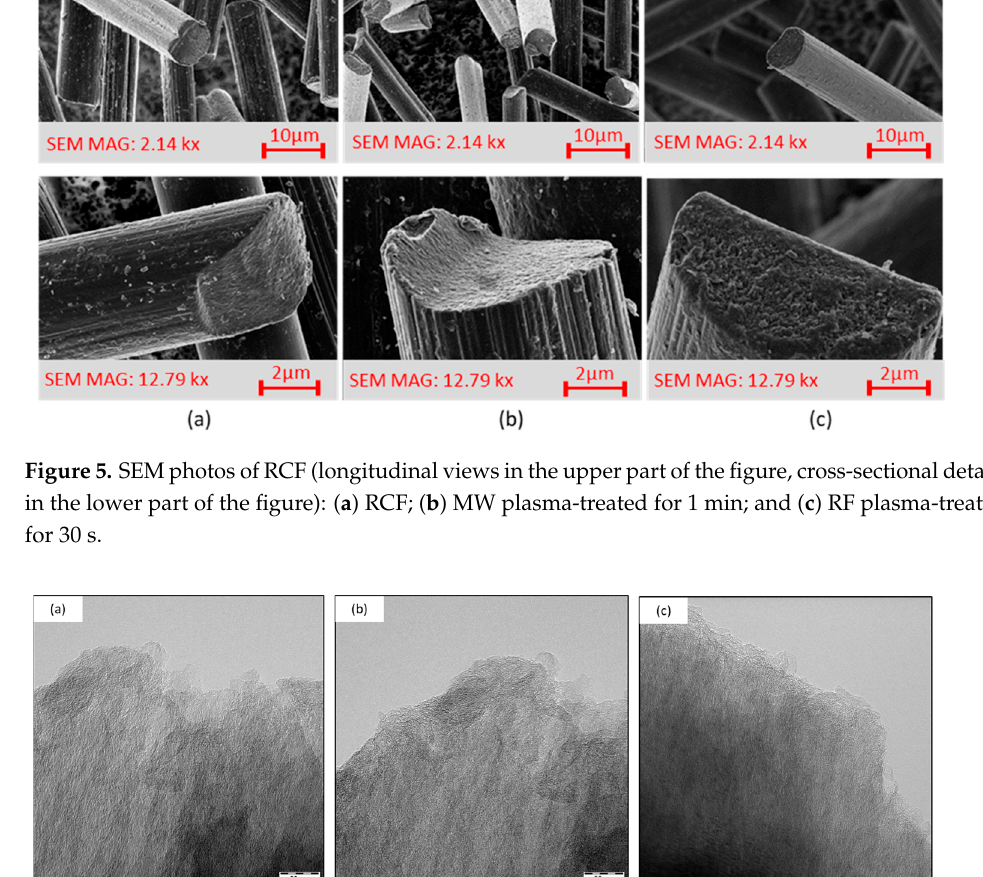
Figure 5. SEM photos of RCF (longitudinal views in the upper part of the figure, cross-sectional details in the lower part of the figure): ( a ) RCF; ( b ) MW plasma-treated for 1 min; and ( c ) RF plasma- treated for 30 s.